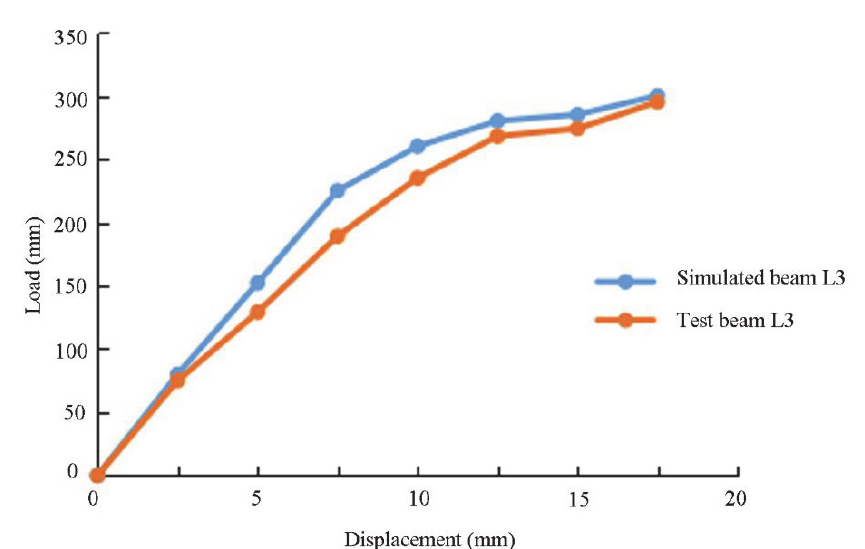
Figure 4: The load-deflection curve of L3.